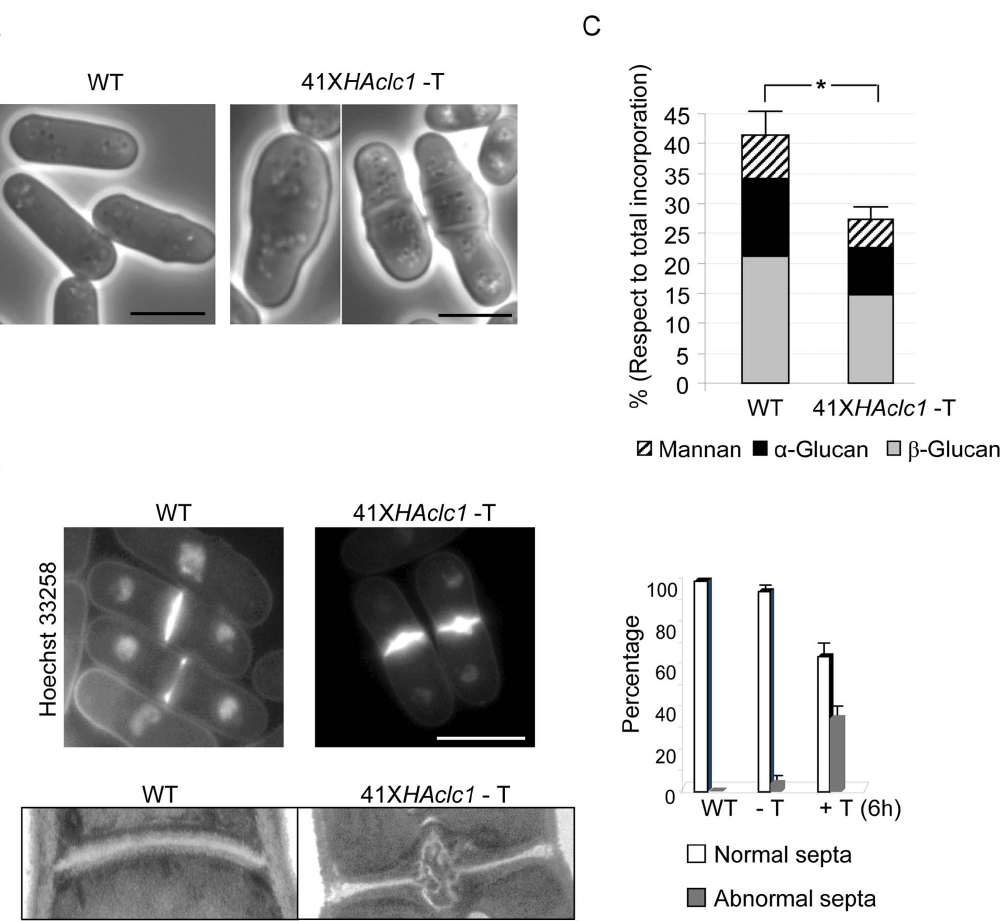
Figure 4. Morphology and cell wall synthesis are abnormal in 41X HAclc1 cells. A. Phase-contrast microscopy of wild-type and 41X HAclc1 cells grown in the absence of thiamine. B. Upper left panel, Hoechst 33258 staining of cells from the control and mutant strains grown in the absence of thiamine. Right panel, quantification of normal and abnormal septa in wild-type and mutant cells grown in the absence or the presence of thiamine for six hours; a minimum of 100 septa were scored in each of three independent experiments. Lower panel, electron microscopy of septa from the indicated strains. C. Cell wall analysis of wild-type and 41X HAclc1 cells. The graph represents the percentage of incorporation of radioactivity into the cell wall polysaccharides of cultures grown in the absence of thiamine and the presence of 14 C-glucose. The experiment was performed five times with duplicates. The standard deviation and statistical significance (*, p , 0.01. Student’s t-test) for the total incorporation in the cell wall is